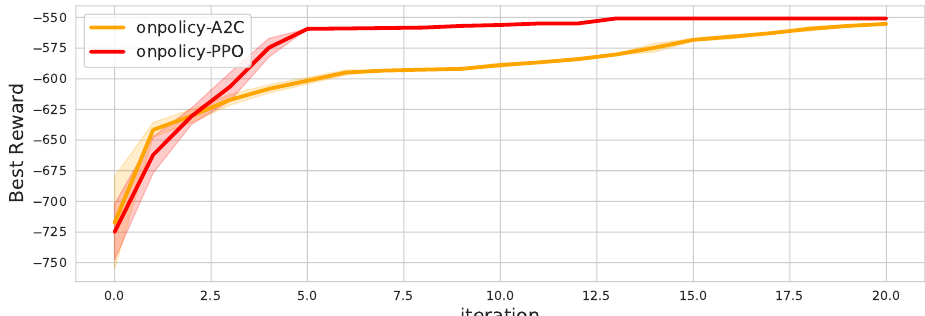
Figure A3. Effect of policy network for 20 samples in 5 robots and 50 tasks problem.